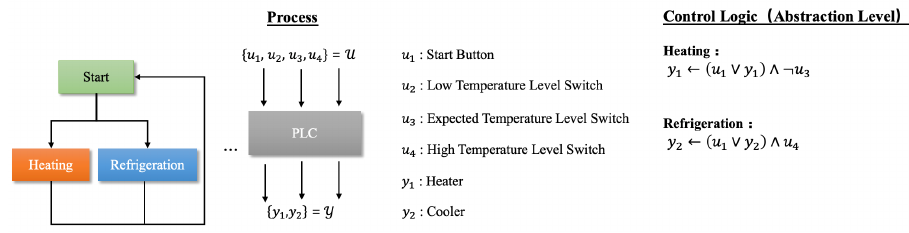
Figure 3. The Process and Control Logic of the Example System.